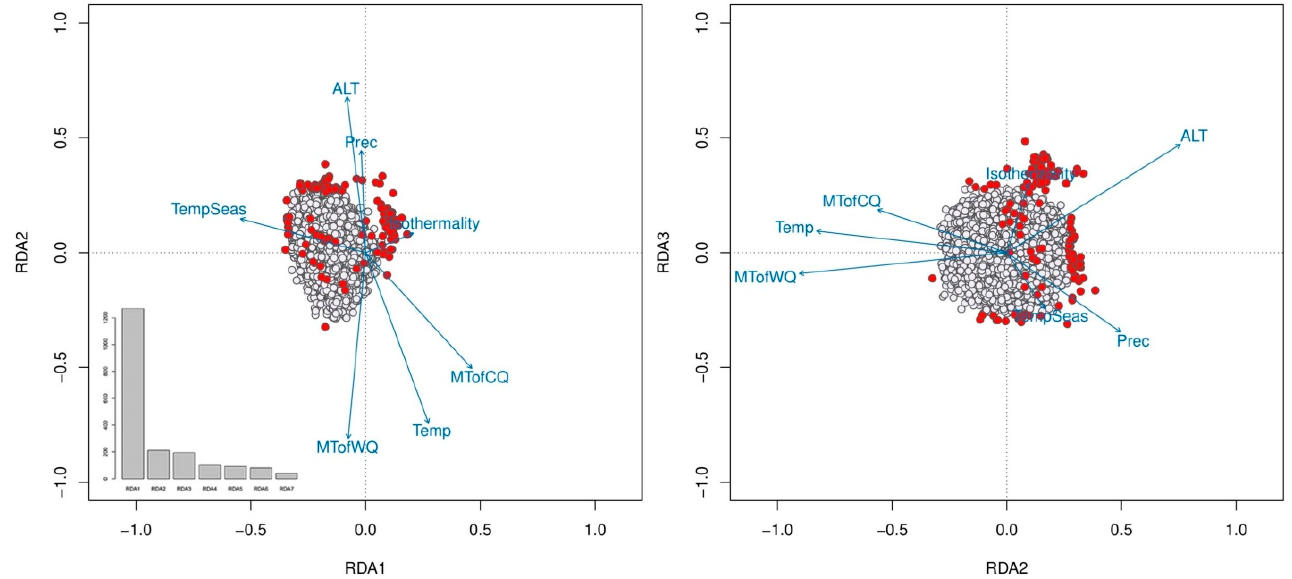
Figure 5. The eigenvalues of the first three RDA axes and projection of SNPs on RDA1 and RDA2 ( left plot ) and RDA2 and RDA3 ( right plot ). Significant SNPs are highlighted in red.